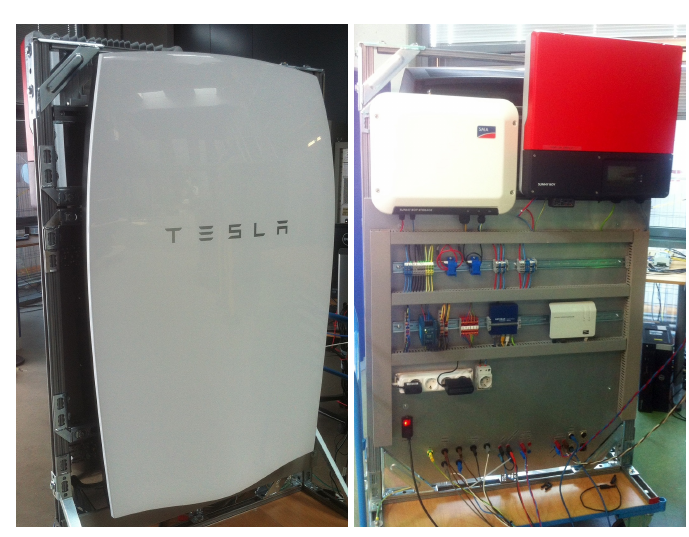
Figure 16. Laboratory setup with the Tesla Powerwall and the Sunny boy storage